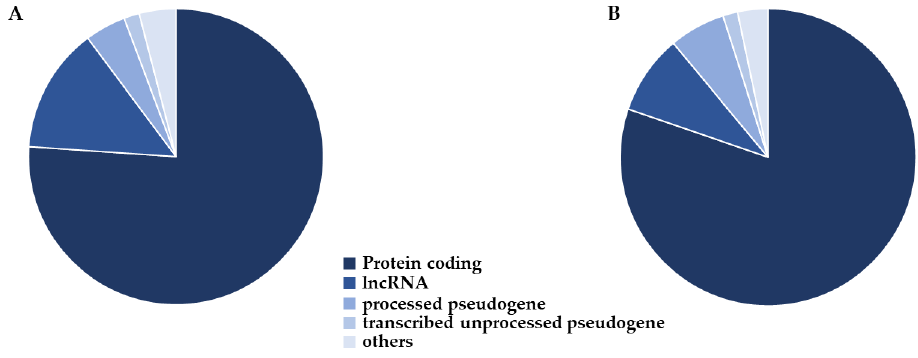
Figure 1. Biotype distribution in the dataset. The biotype characterization of the probes before ( A ) and after ( B ) feature selection. The two distributions are quite close to each other. Most of the probes are protein-coding. Also, large amounts of lncRNA, processed pseudogenes and transcribed unprocessed pseudogenes are present.